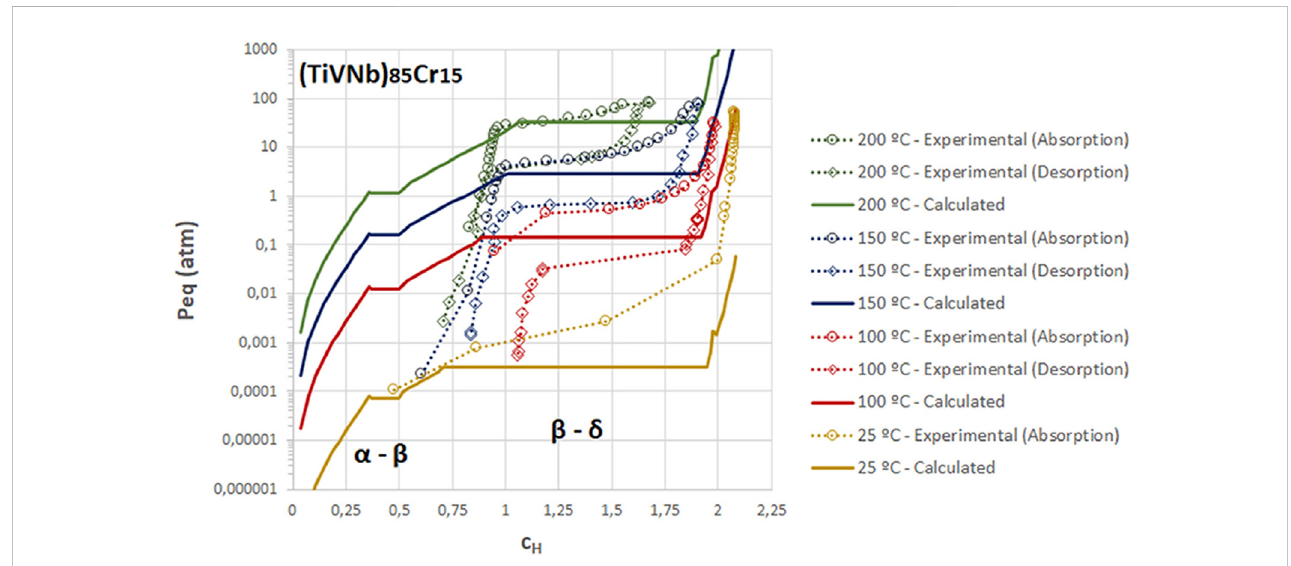
FIGURE 3 Comparison between calculated and experimental PCT curves for (TiVNb) 85 Cr 15 at different temperatures (Zepon et al., 2021).